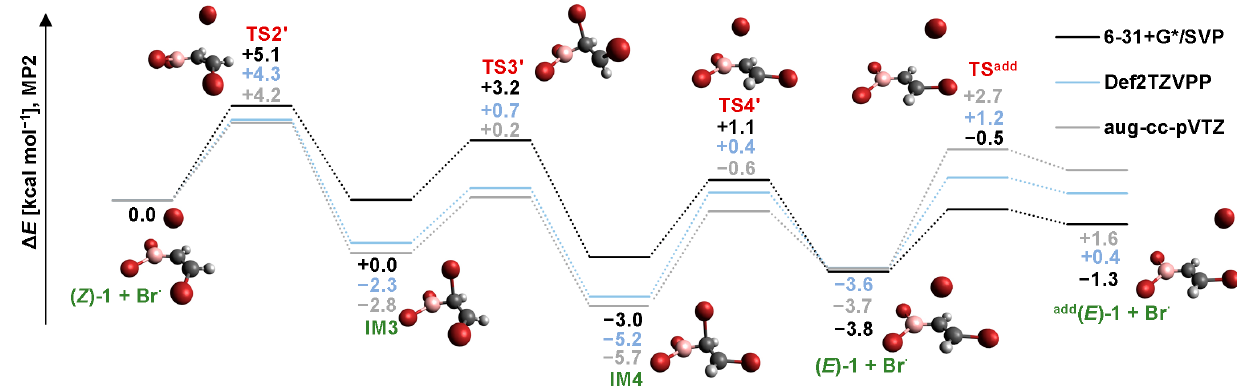
Figure 6. MP2 total electronic energy profile for bromine radical addition to the “boron end” of ( Z )-1 , followed by clockwise rotation around C–C bond. For a key to atom color scheme, cf. caption of Figure 1.